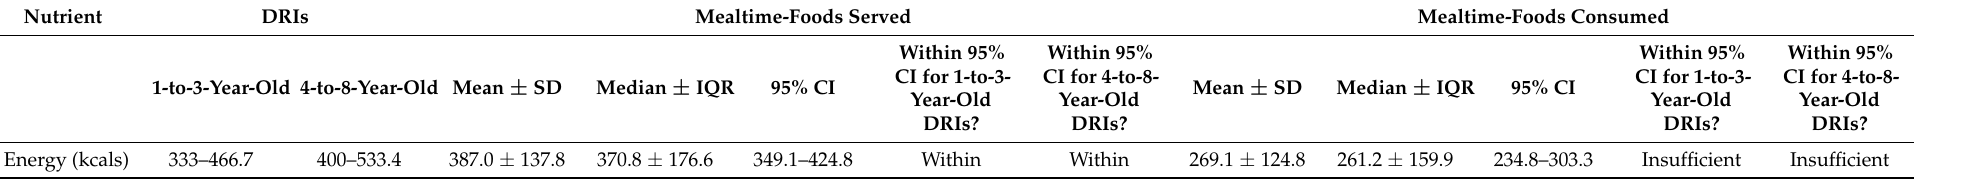
Table 3. Energy (kcals) of daily foods served and consumed in Oklahoma Family Child Care Homes ( n = 51 a ).